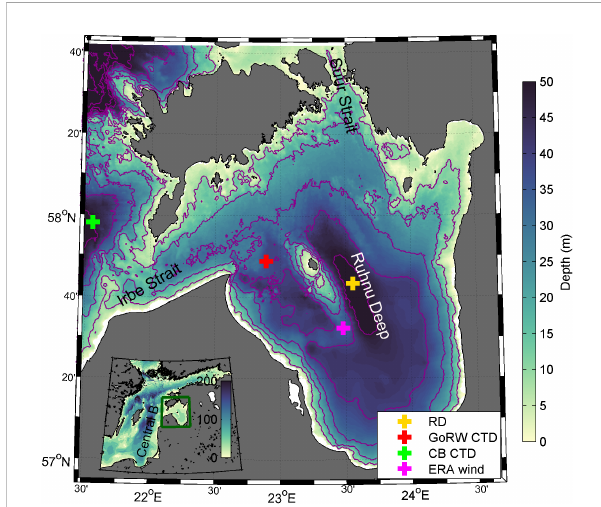
FIGURE 1 Locations of CTD stations in the Central Baltic (CB) and the western Gulf of Riga (GoRW), ERA wind data acquisition (ERA wind) and the mooring in the Ruhnu Deep (RD) are shown. Colormap shows the sea depths; isolines are shown by 10 m